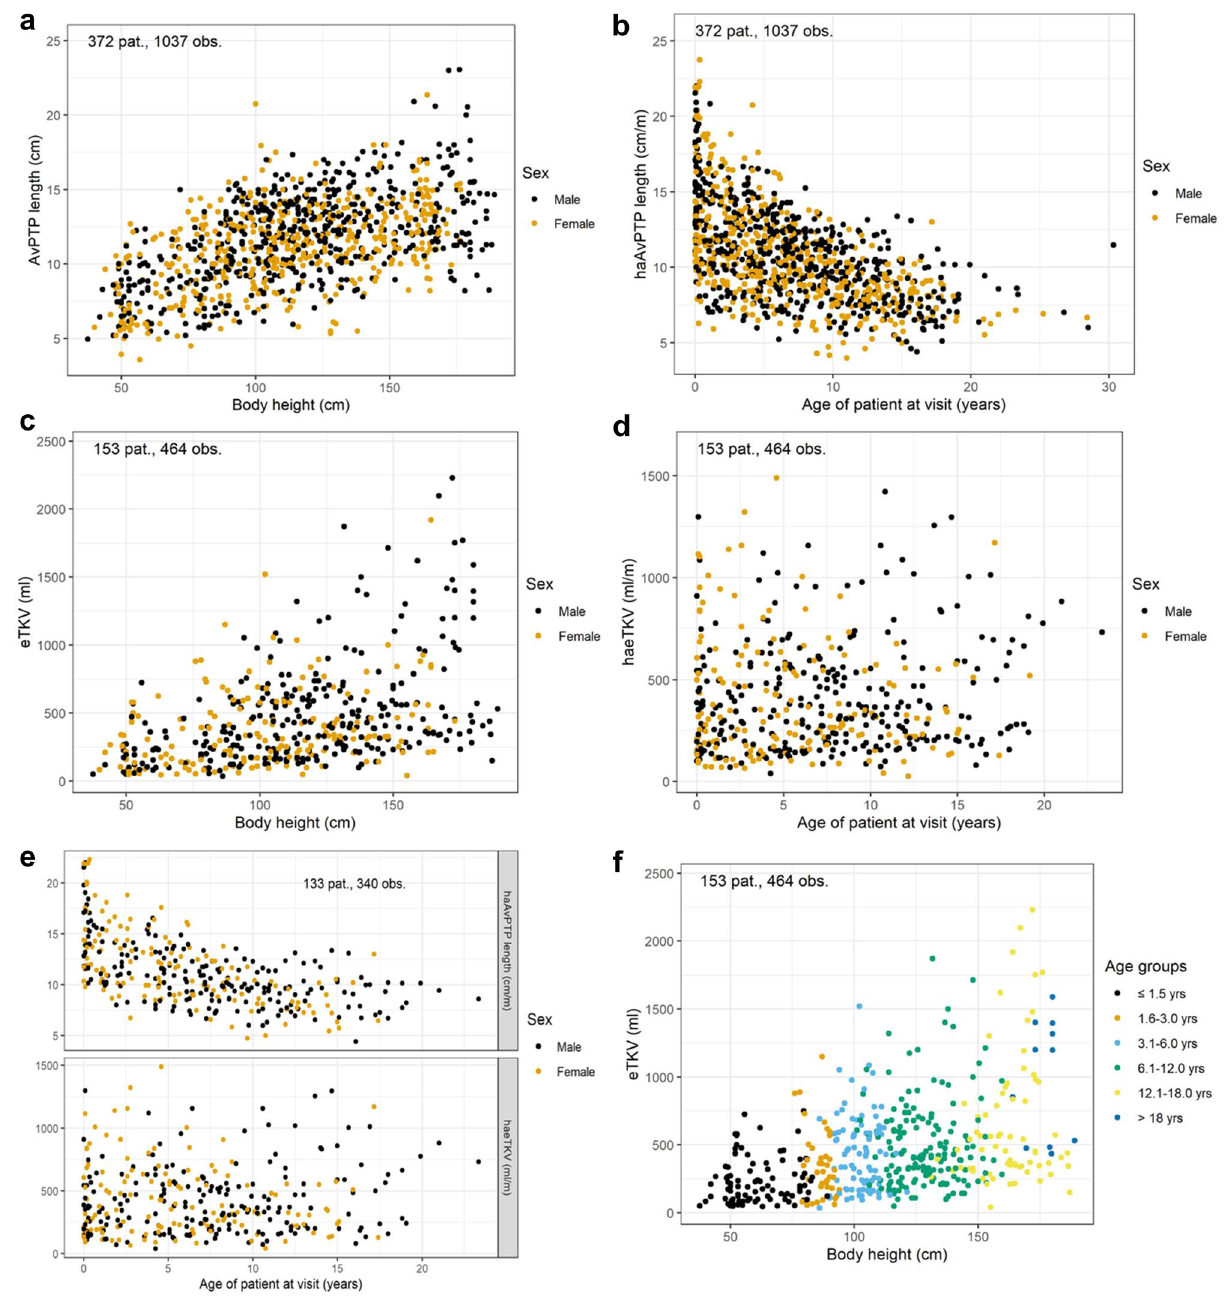
Figure 1. Sonographic findings over time: Average kidney pole-to-pole length (avPTP length) increases with body height ( a ), height-adjusted avPTP length decreases with age ( b ). Estimated total kidney volumes (eTKV) increase with body height ( c ), height-adjusted value (haeTKV) distribution is stable, although variable, in children ( d ). These findings were confirmed in a subset of patients in whom both haPTP length and haeTKV were available ( e ). The distribution of eTKV showed a similar relation to body height in different age groups ( f